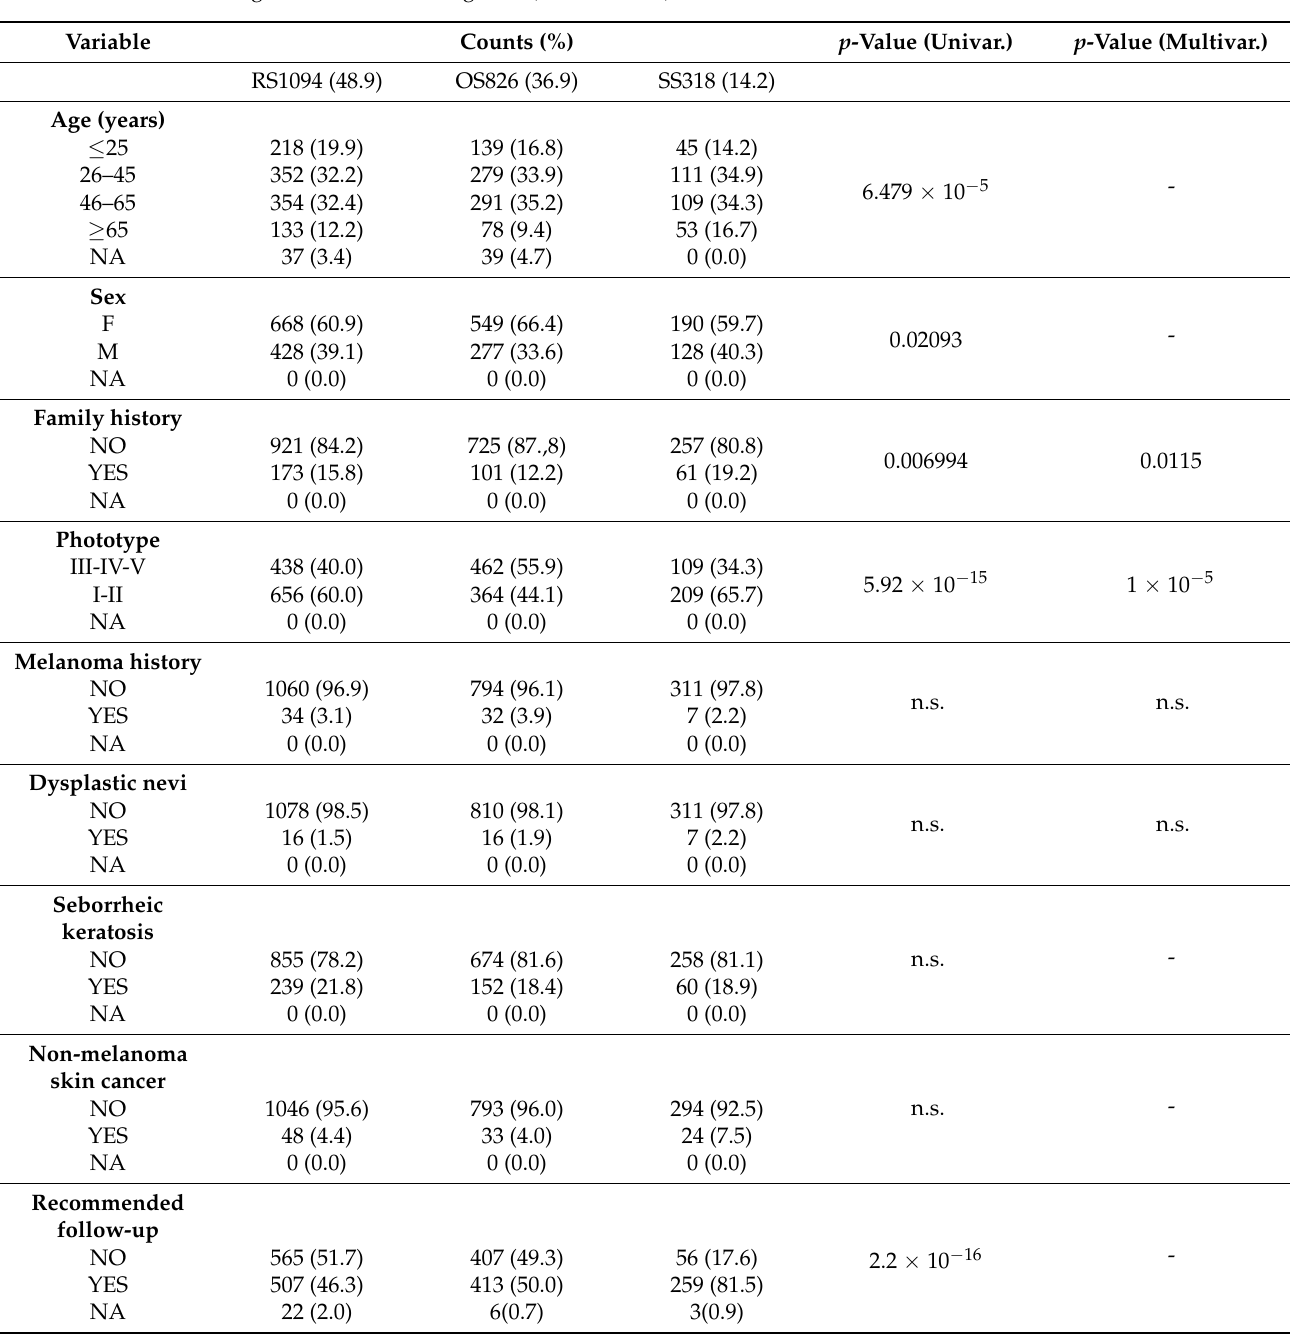
Table 2. Frequencies of occurrence of clinical outcomes comparing RS, OS, and SS, with p -values indicating statistical significance of both univariable and multivariable models. Dash indicates the variable is not included in the model, while n.s. stands for not significant. NA, missing data (not